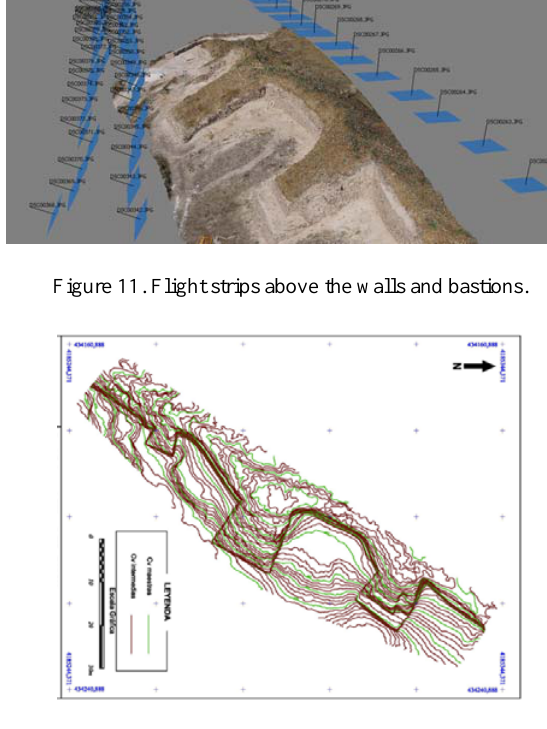
Figure 12. Contour map (derived from DEM), 0.25 m interval, in a sector of the oppidum wall (Buzdugan,